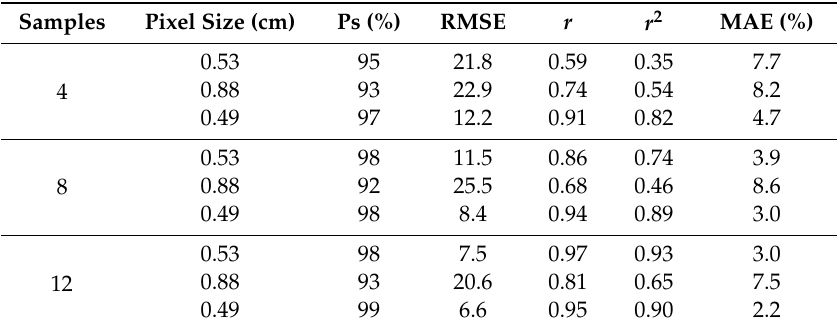
Figure 3. Green pixel filtering in channel a* , from left to right: ( a ) RGB image; ( b ) threshold = 0; ( c ) threshold = mean ( a* ); ( d ) threshold = mean ( a* ) + mean ( a* ) / 4. Table 2. Precision (Ps) in corn plant count with respect to the sensor and pixel size 44 days after sowing (V5 stage).